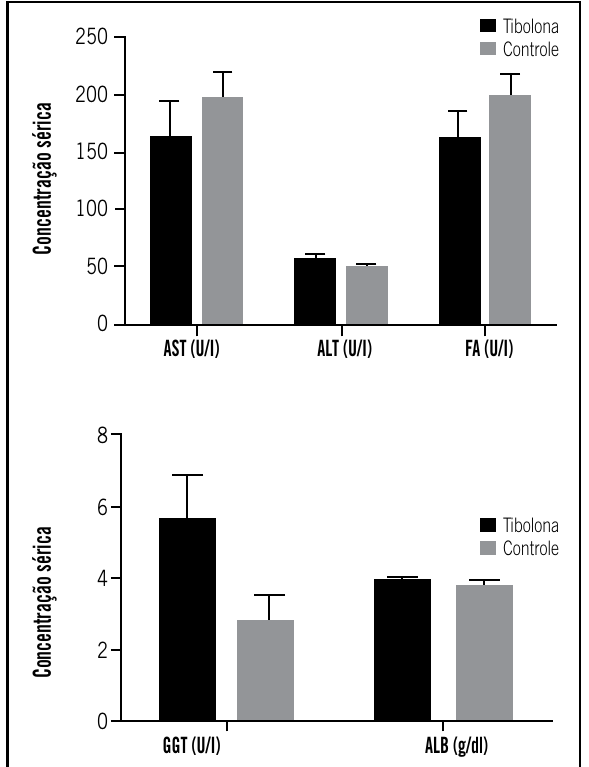
Figura 1 – Visualização do procedimento de medição das fibras do tecido muscular esquelético mediante Image-Pro Plus 4.5 (A, B, C) grupo tibolona; (D, E, F) grupo-controle; (A, D) Segmentação por cor do pixel; (B, E) delineamento automático das fibras; (C, F) imagem das fibras mensuradas. HE, aumento original 400×. HE: hematoxilina e eosina.